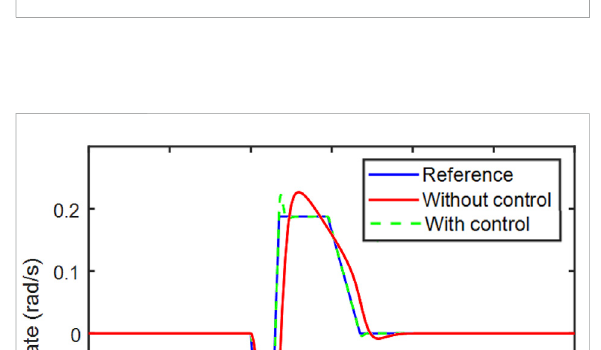
FIGURE 18 Comparison of the phase portrait.